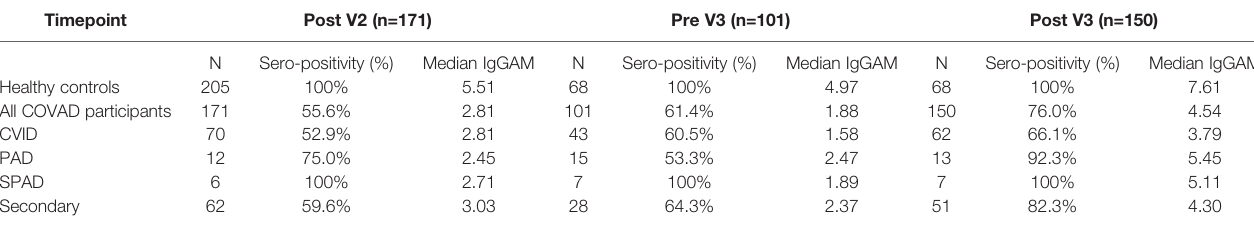
TABLE 2 | Summary of serological response to third primary immunisation in infection-naive COV-AD participants.